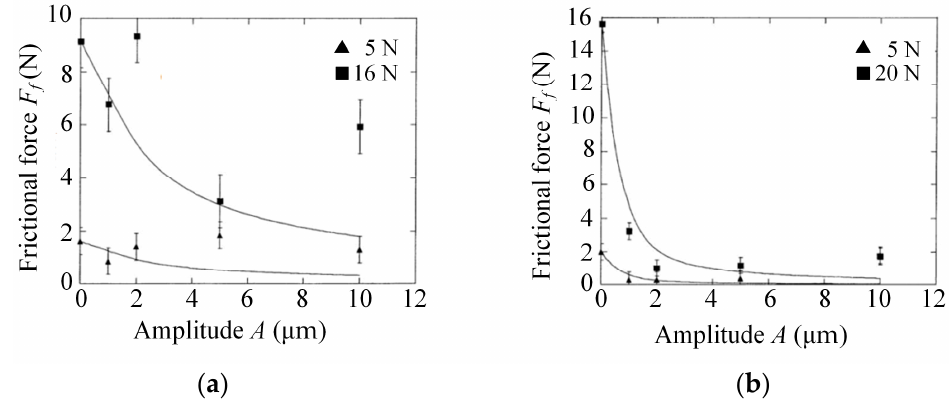
Figure 8. Effect of ultrasonic vibration on the frictional force between sliding elements. (Adapted with permission from Ref. [30]. 2022, Elsevier). ( a ) Transverse vibration, ( b ) Longitudinal vibration. (Friction pairs: stainless steel-tool steel, sliding speed 50 mm/s, vibration frequency 20 KHz).